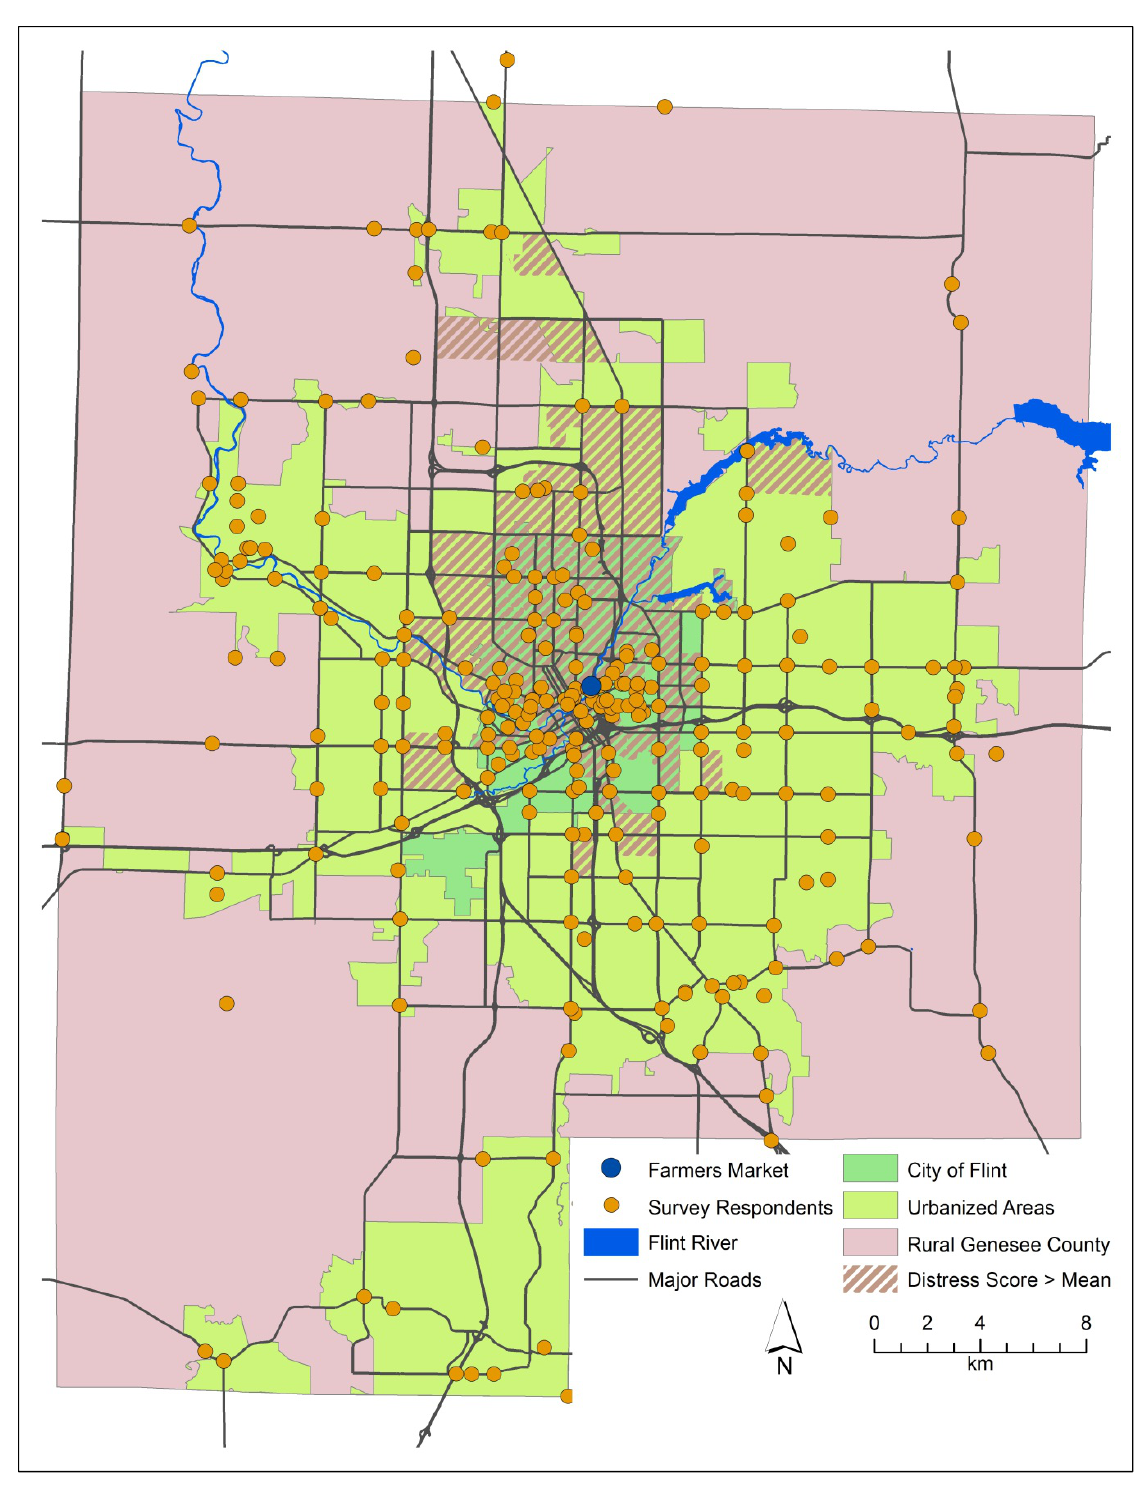
Figure 1. Spatial Distribution of Customers at the Flint Farmers’ Market by Level of Urbanization and Presence of Above-Average Neighborhood Socioeconomic